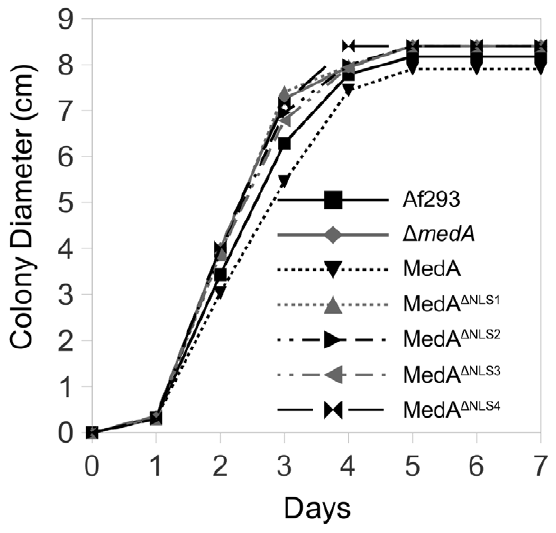
Figure 4. Mycelial growth of A.fumigatus is not affected by MedA nuclear localization. YPD agar plates were spot inoculated with the indicated strains and the colony diameter measured daily. Af293 is the A. fumigatus wild type strain; MedA, MedA D NLS1 , MedA D NLS2 , MedA D NLS3 , and MedA D NLS4 indicate expression of the corresponding construct under the control of the medA(p) in the D medA strain.